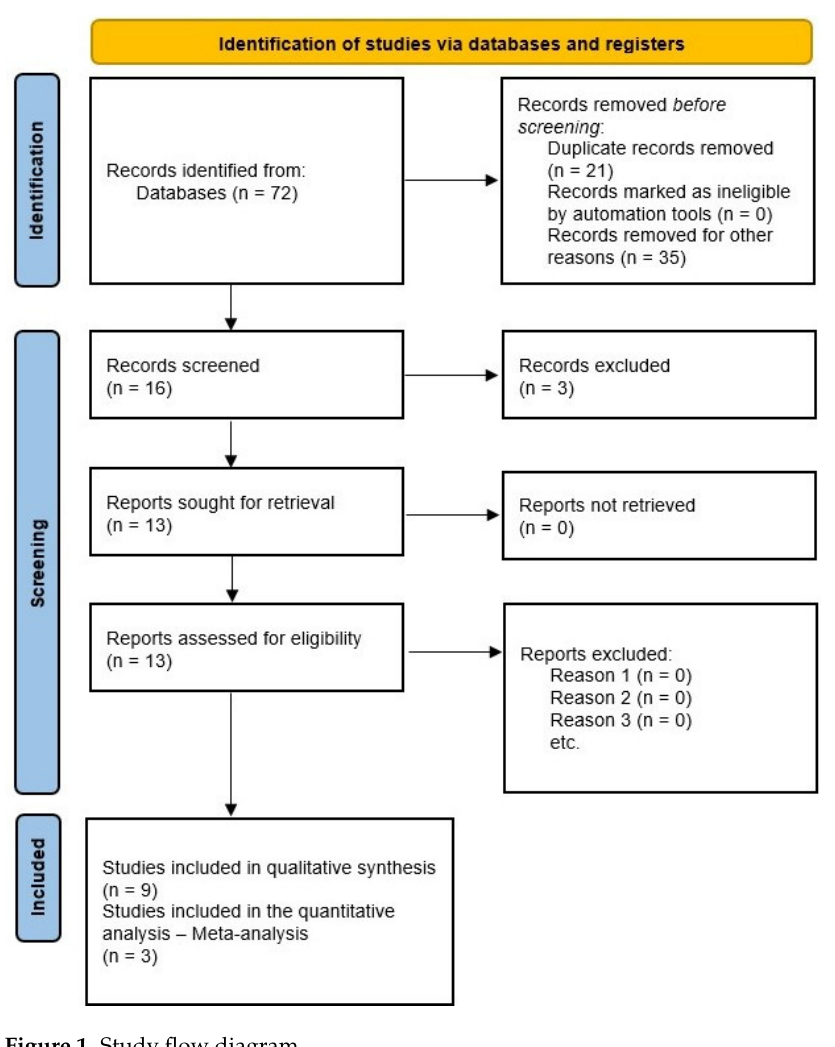
Figure 1. Study flow diagram.